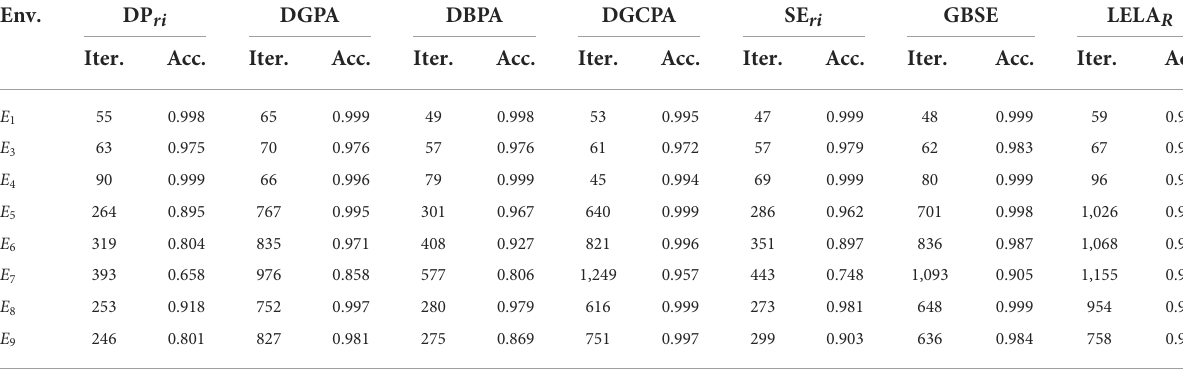
393 253 0.918 246